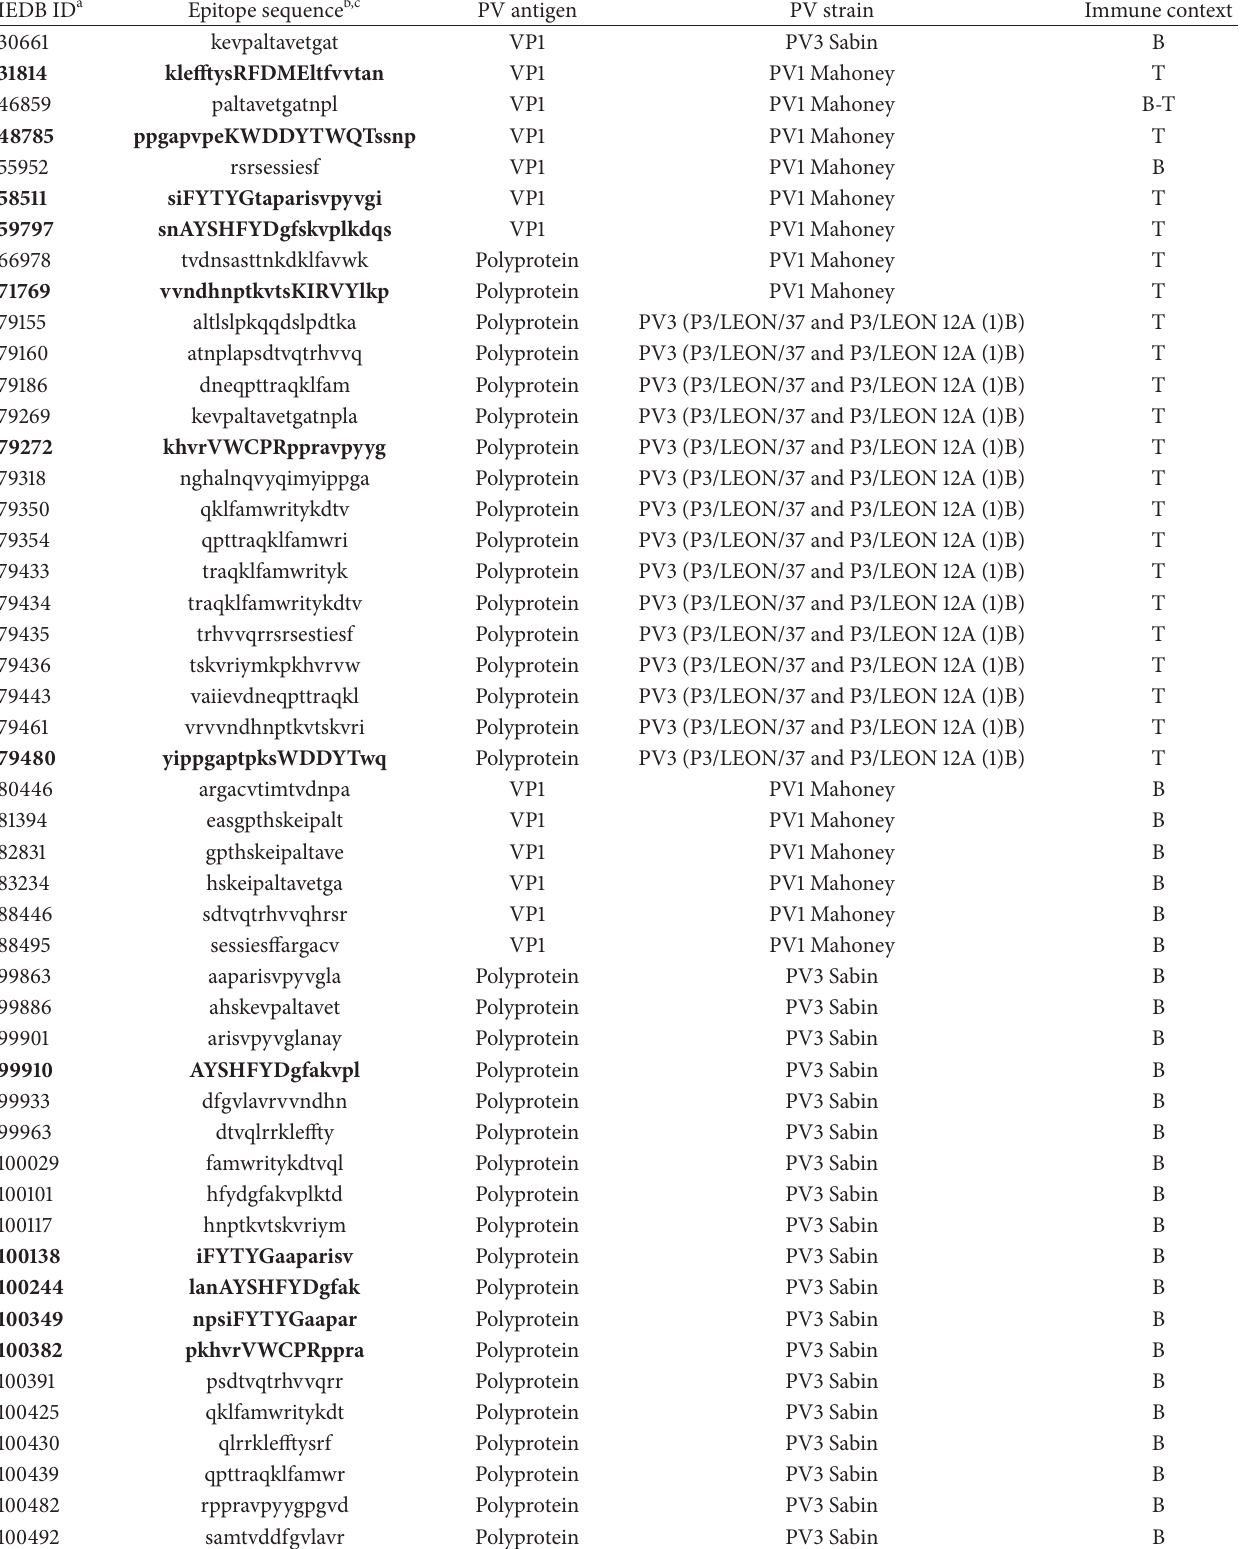
Table 2: Twelve pentapeptides unique to PV1, Mahoney strain, and absent in the human proteome are distributed among twenty PV-derived epitopes recognized by human sera and/or T